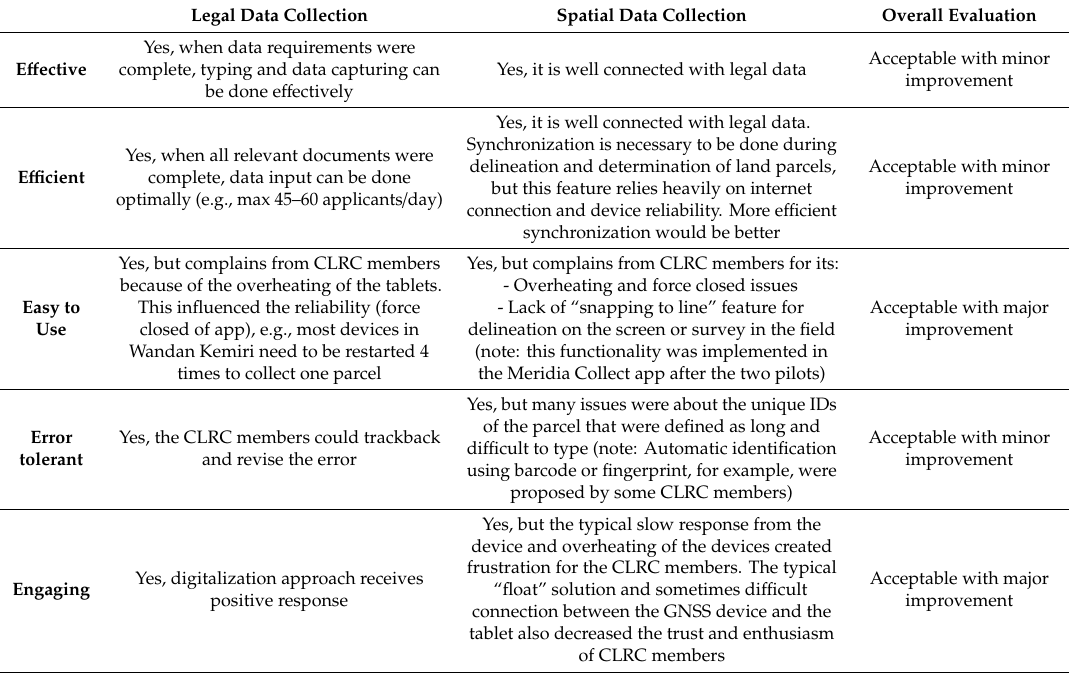
Table 7. Assessment of usability indicators during the field data collection (as-is)